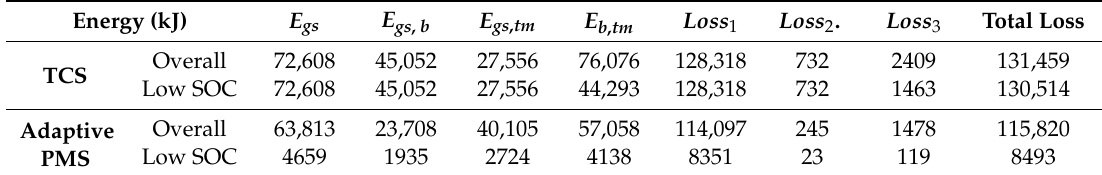
Table 9. Energy usage comparison of TCS and adaptive PMS for 9 UDDS.